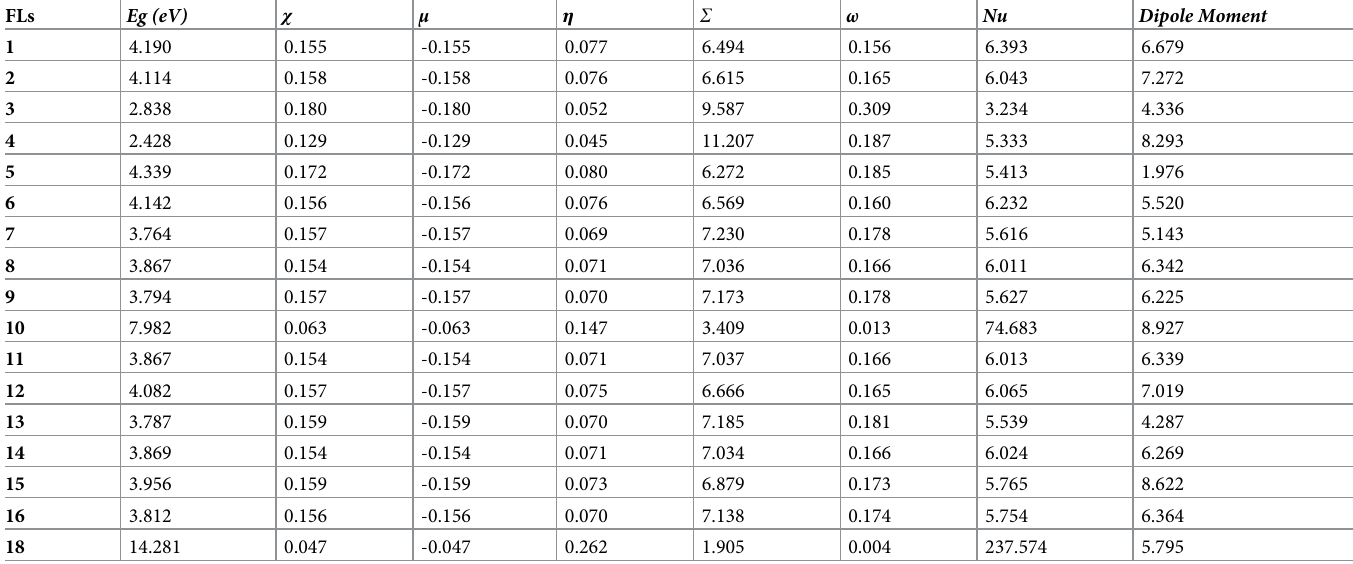
Table 7. Quantum chemical descriptors of the flavonoid derivatives calculated using DFT/B3LYP hybrid functional was used together with 6–311++G(d,p) basis